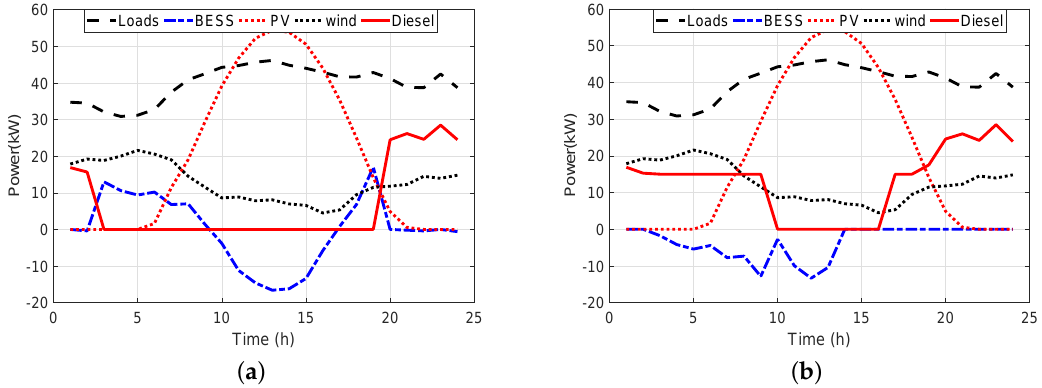
Figure 6. Power plan of studied hybrid system in simulation 1 ( a ) the DP approach; ( b ) the rule-based